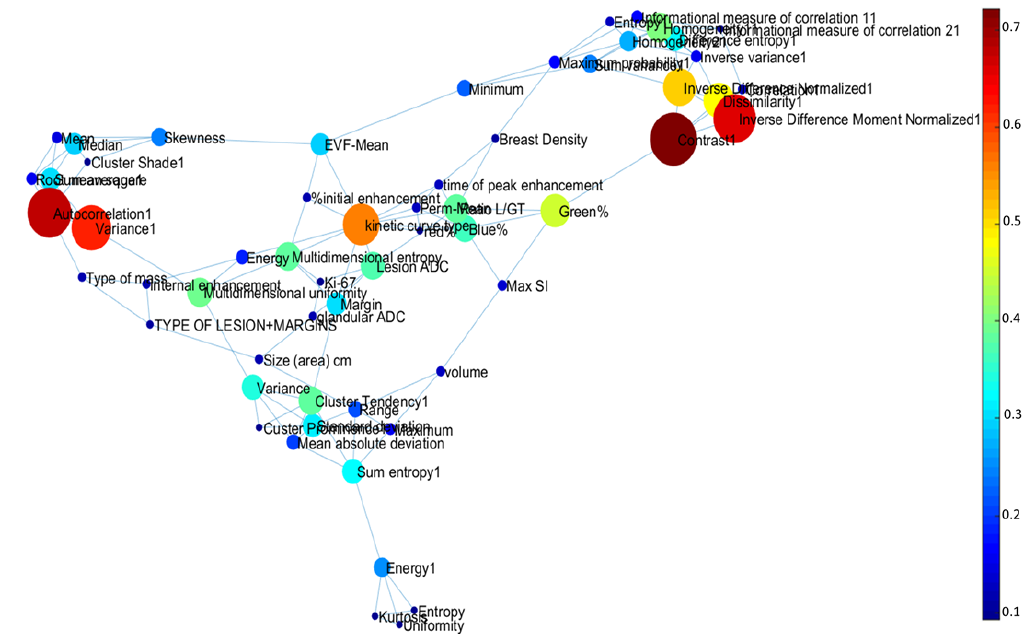
Figure 8. Visualization of the Integrated Radiomic Informatic System (IRIS) single parameter radiomics complex interaction network. The nodes represent different IRIS parameters, with edges corresponding to inter-parametric relationships.